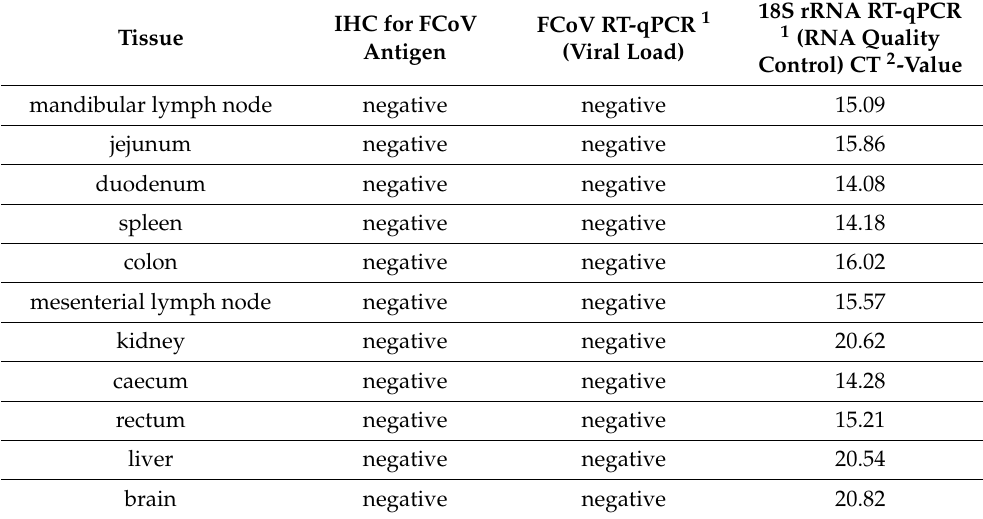
Table 3. Results of immunohistochemistry (IHC) for feline coronavirus (FCoV) antigen and quantita- tive reverse transcriptase PCR (RT-qPCR) in different tissues compared to control